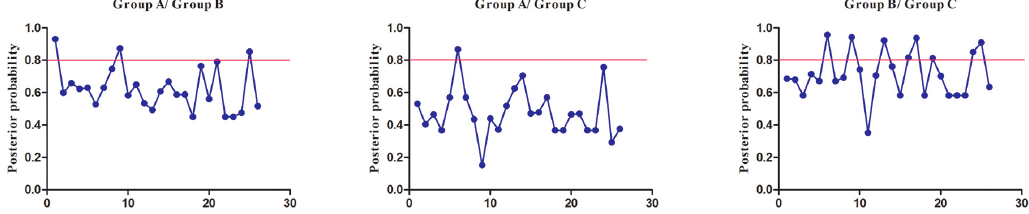
Figure 5. Site-specific prediction for type-I functional divergence between groups of SmSABATH . The X-axis represents the locations of sites. The Y-axis represents the probabilities of each group. The red line indicates a cutoff = 0.80.